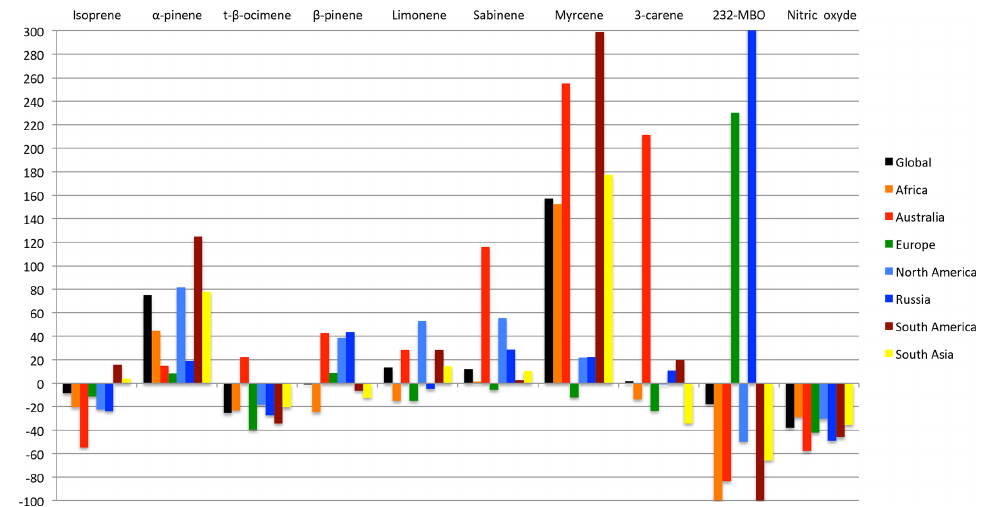
Figure 5. Global and regional relative emission differences (%) between the sensitivity simulation (PFT-CLM4) and the reference simulation for isoprene, monoterpenes, 232-MBO, and nitric